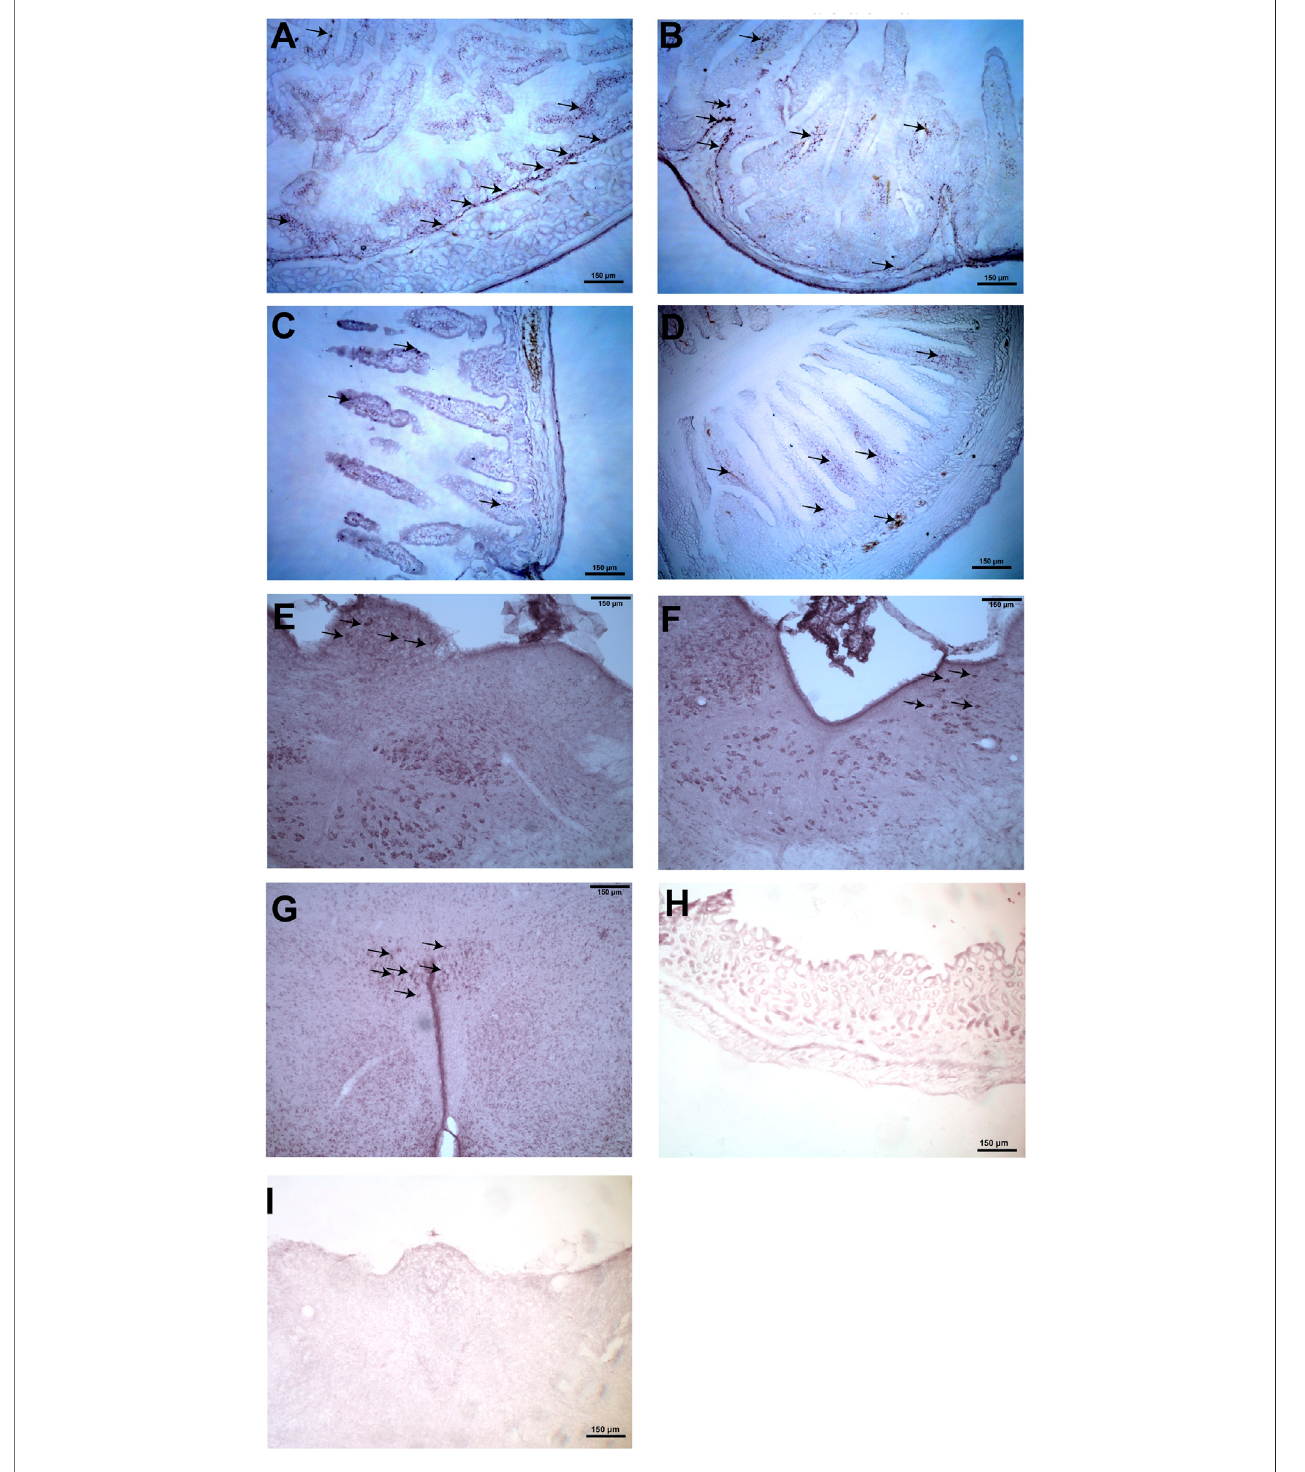
FIGURE 3 | Representative photomicrographs illustrating nesfatin-1 immunoreactive cells (arrows) in the stomach, duodenum, ileum, colon, brainstem and hypothalamusin Suncusmurinus . (A) Nesfatin-1immunoreactivecellsdetectedinthegastricantrum, (B) duodenum, (C) ileum, (D) colon, (E) areapostrema, (F) nucleus tractus solitarius, and (G) hypothalamic paraventricular nucleus. Negative control section in the (H) gastric antrum and (I) brainstem that omits the primary antibody.